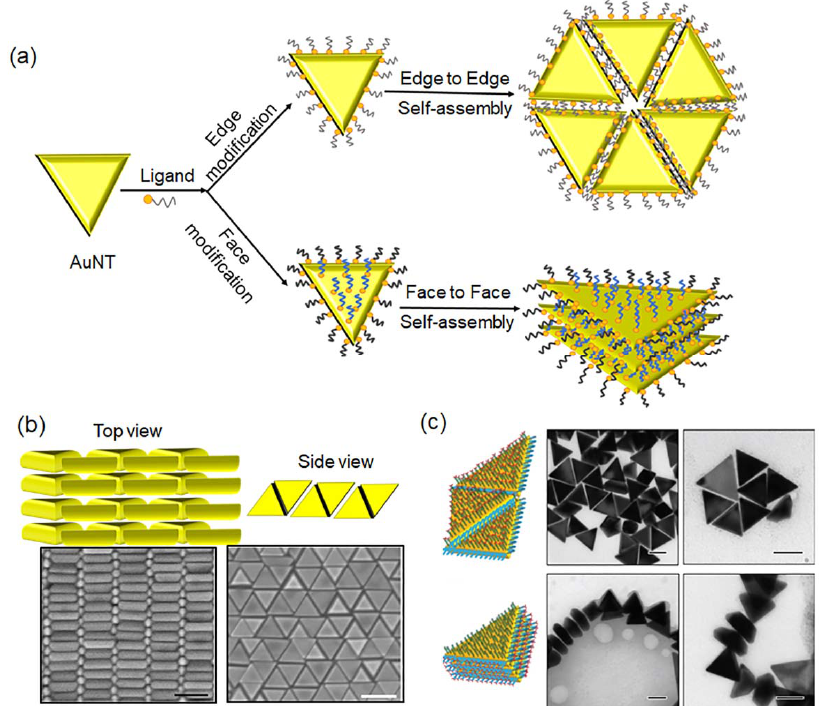
Figure 4. ( a ) Schematic diagram of gold nano triangle self ‐ assembly process. ( b ) Self ‐ assembly of gold nano triangles in the presence of CTAC micelles. Adapted with permission from Ref. [46]. Copyright © 2022 American Chemical Society; ( c ). Self ‐ assembly of DNA ‐ modified AuNTs into ordered structures. Reprinted with permission from Ref. [78]. Copyright © 2022 MDPI. ( b , c ) Scale bars are 100 nm.